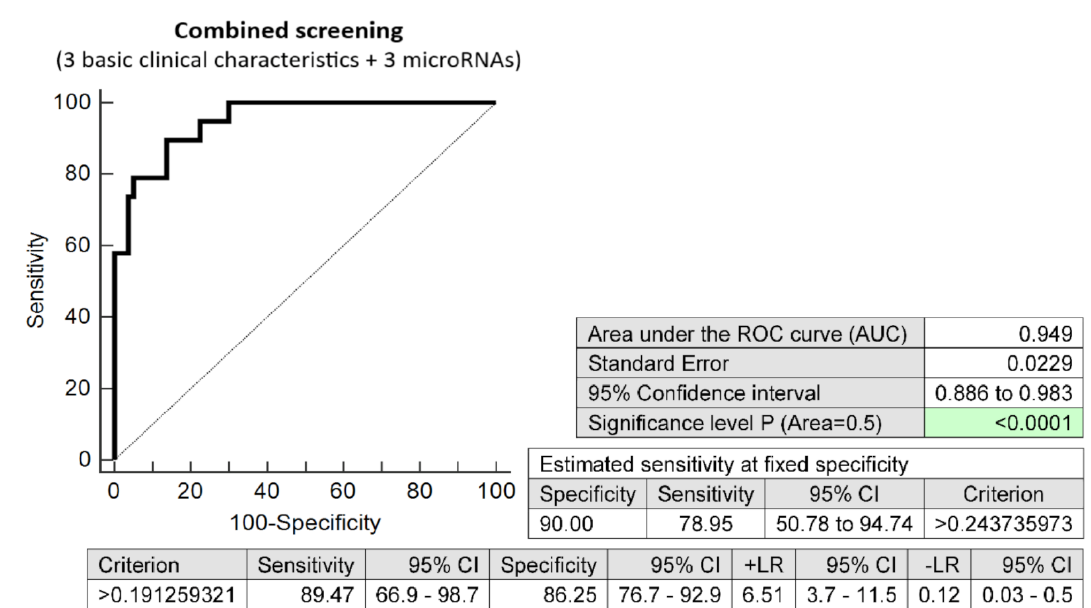
Figure 6. ROC analysis—the combination of 3 basic clinical characteristics (maternal age and BMI values at early stages of gestation and an infertility treatment by assisted reproductive technology) and 3 dysregulated microRNA biomarkers (miR-20a-5p, miR-20b-5p, and miR-195-5p). At a 10.0% FPR, 78.95% pregnancies destinated to develop GDM requiring a combination of diet and administration of appropriate therapy were identified during the first trimester of gestation. This represents 16 out of 20 pregnancies correctly predicted to develop GDM and 8 out of 80 normal pregnancies predicted false positively to develop